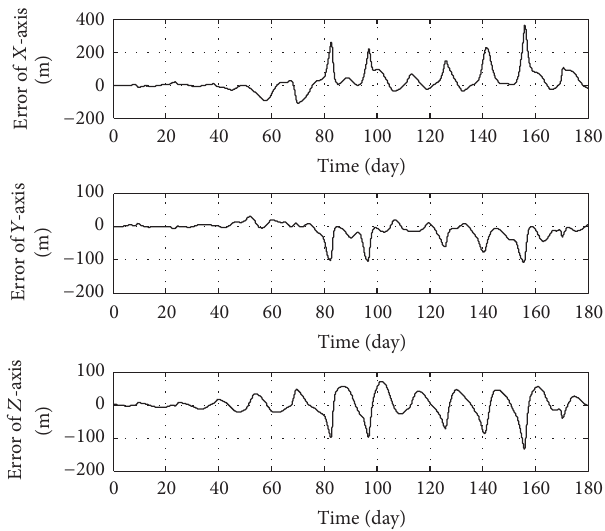
Figure 12: The AOD position error of 𝐿 2 using SR-EKF with 𝑃 0 = 10 −10 .